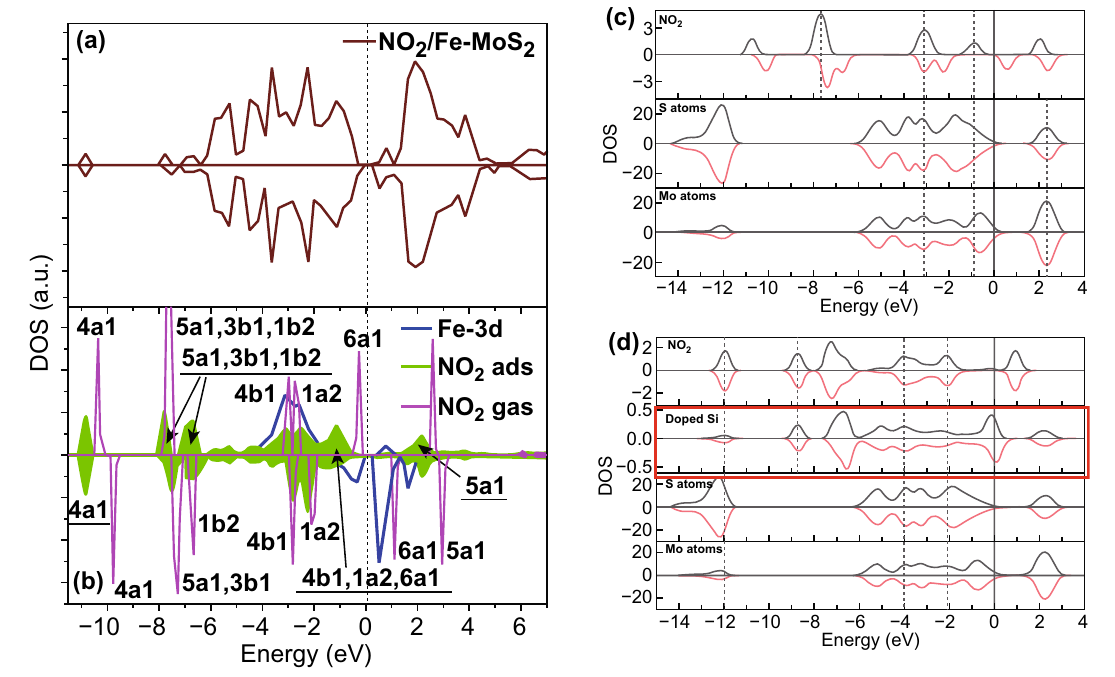
Fig. 8 a, b Total density of states and density of states for Fe-embedded NO 2 molecule. Reproduced with permission from Ref. [296]. Copy- right (2017) Elsevier; Calculated projected density of states c with NO 2 adsorbed on monolayer MoS 2 , d Si-doped MoS 2 . Reproduced with per- mission from Ref. [297]. Copyright (2016)